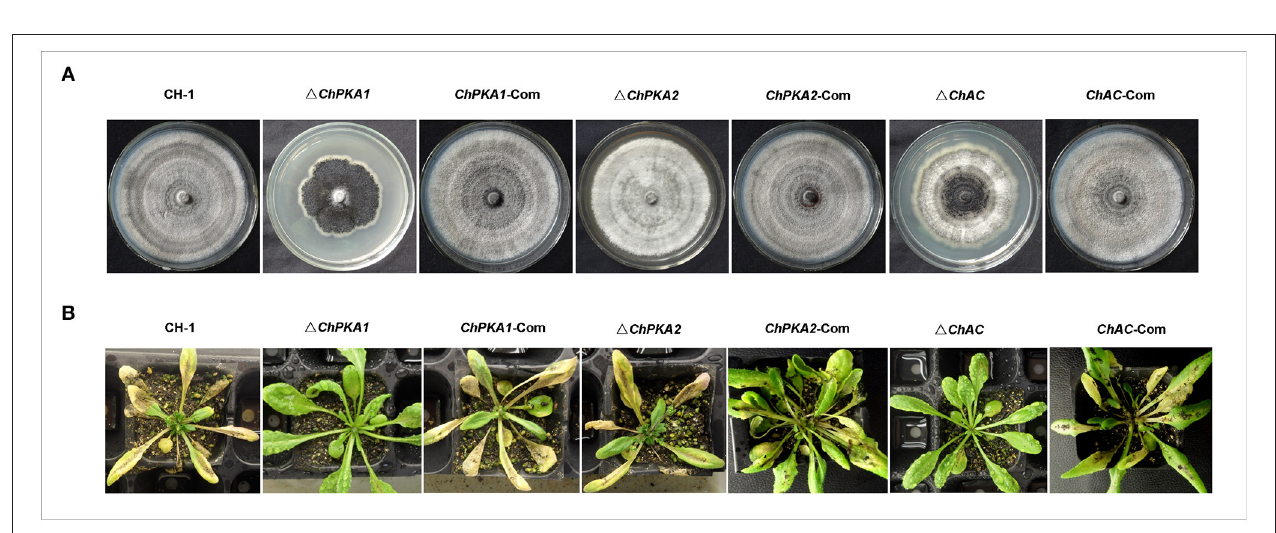
FIGURE 2 | Phenotypes of wild type strain CH-1, ChPKA1 deletion mutant ∆ ChPKA1 , ChPKA2 deletion mutant ∆ ChPKA2 , ChAC deletion mutant ∆ ChAC , and complementary strains ChPKA1 -Com, ChPKA2 -Com and ChAC -Com. (A) Colony morphology of indicated strains. These strains were grown on PDA medium at 25 ◦ C for 14 days. (B) Pathogenicity assays of indicated strains. 4-weeks-old A. thaliana were respectively sprayed with 1ml conidial suspensions (10 6 conidia/ml) of indicated strains and the infected Arabidopsis plants were incubated in darkness and humid chambers at 25 ◦ C for 6 days, and then the symptoms were